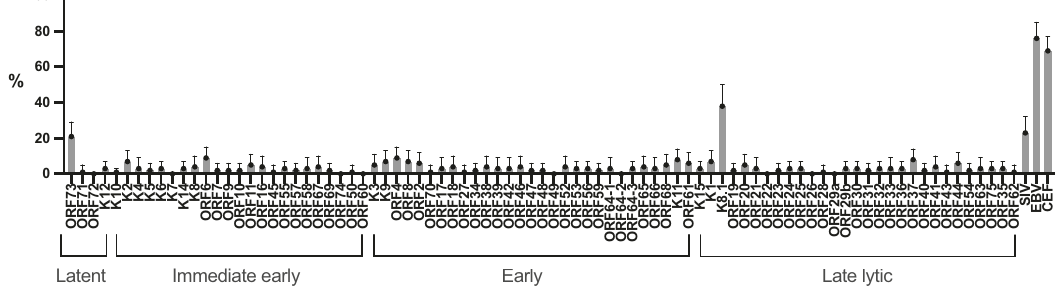
Fig. 3 Proportion of individuals with IFN- γ responses to various KSHV ORFs and controls peptide pools. Dots represent the percentage of individuals reacting to the different KSHV antigens. Error bars represent 95% con fi dence intervals. N = 116 study participants. SIV Simian immunode fi ciency virus, EBV Epstein – Barr virus, CEF CMV + EBV + fl u cocktail. Graph drawn in GraphPad Prism version 8.0.1. Source data are provided as a Source Data fi